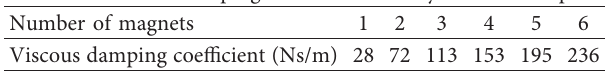
Table 2: Additional damping ratio experimental value of high-rise